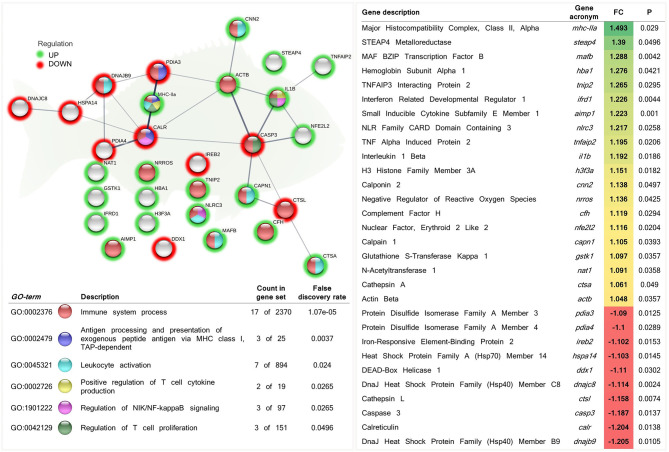
Functional biological network of differentially expressed genes (DEGs) recognized by their involvement in the immune response in the skin of juvenile gilthead seabream (Sparus aurata) fed a diet supplemented with a blend of garlic essential oil, carvacrol, and thymol. Green-shaded nodes represent up-regulated genes and red-shaded nodes represent down-regulated genes. Graphic keys and network stats: number of nodes = 30; number of edges = 24; average node degree = 1.6; average local clustering coefficient = 0.4; expected number of edges = 9; PPI enrichment p-value = 1.25e-05. Gene Ontology (GO) definition, count of DEGs within the biological process and respective false discovery rate are described in the graphical figure legend (bottom left). For details, please refers to Supplementary Table 4. Gene description, respective acronym, fold-change intensity (FC), modulation (color scale), and P-value are described (right).